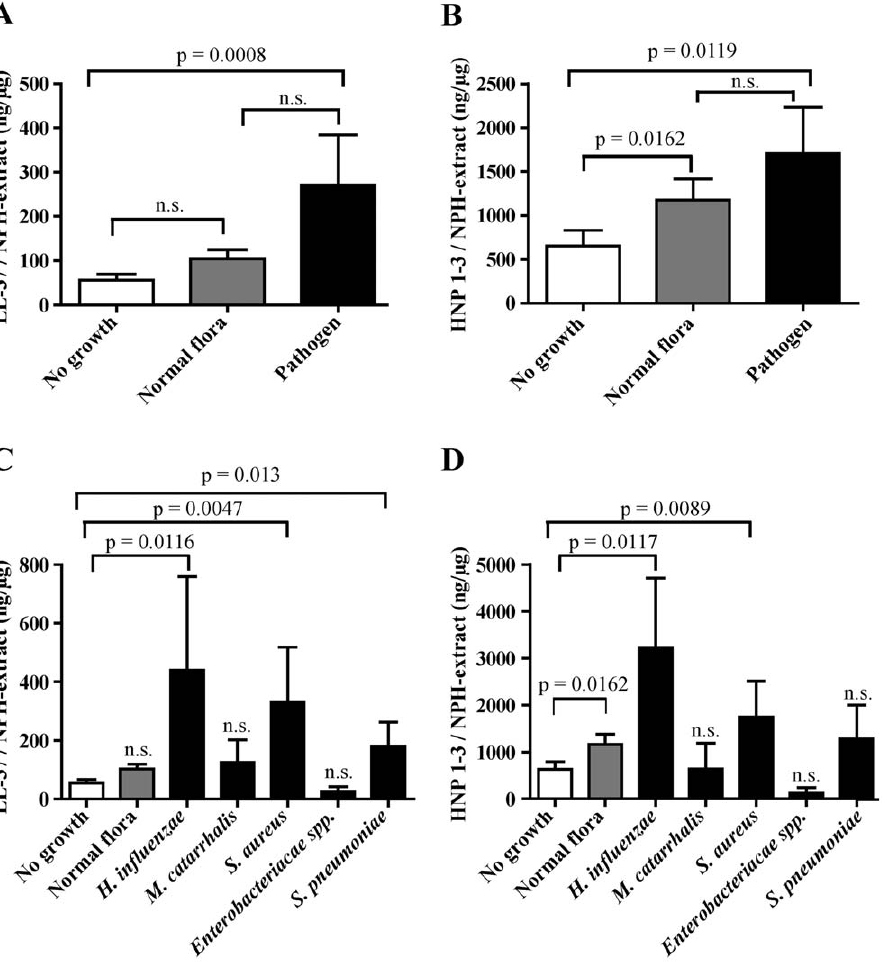
Figure 1. Bacterial composition and levels of AMPs in nasal fluid. AMP levels in nasal fluid samples were determined by Western blotting and subsequent densitometric measurements and the results were correlated to bacterial growth in the nasopharynx. The levels of LL-37 (A and C) and HNP1–3 (B and D) are expressed as nanogram peptide/total nasal fluid extract ( m g). The group that exhibited growth of primary pathogens was further subdivided according to bacterial species (C and D). The number of samples included (no growth, normal flora, and pathogen respectively) are n=44, 43, and 30 (A), n=39, 34, and 28 (B). The number of samples included (no growth, normal flora, H. influenzae , M. catarrhalis , S. aureus , Enterobacteriacae , S. pneumoniae respectively) are n=44, 43, 8, 3, 11, 3, 5 (C), n=39, 34, 7, 3, 11, 2, 5 (D). Statistical analyses were performed with Mann Whitney U-test and the standard error of the mean (SEM) was used to estimate sample variation.